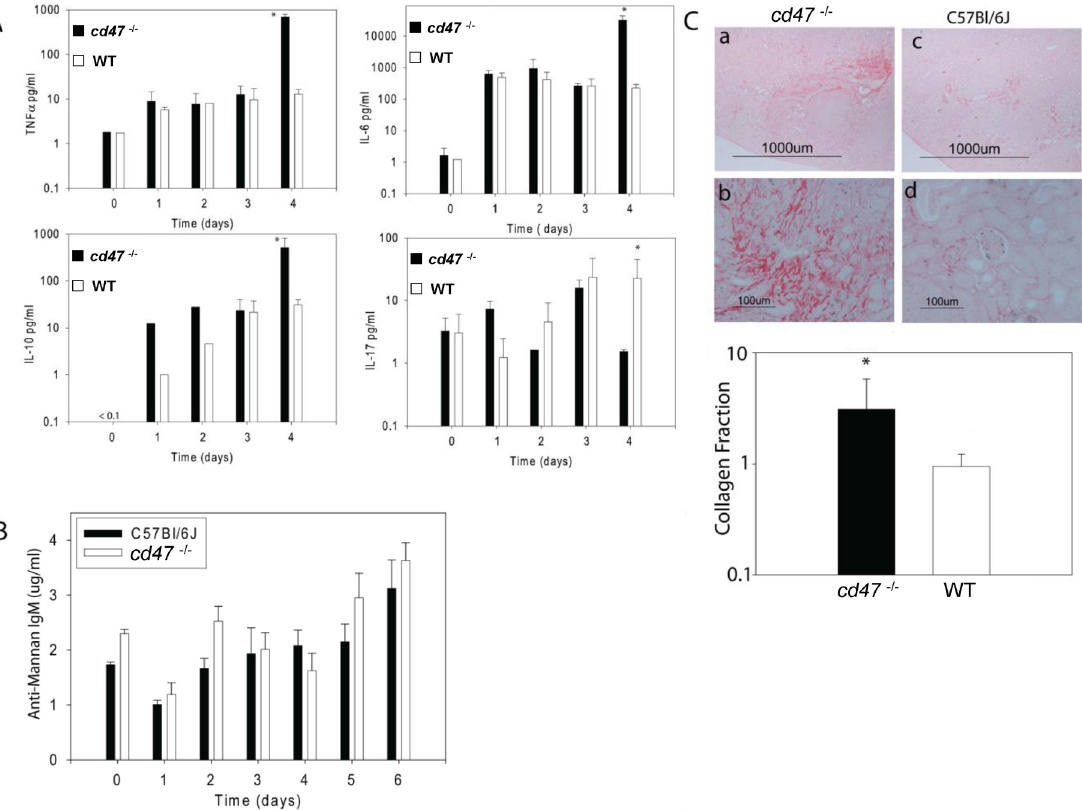
Fig 3. Inflammatory responses in WT and cd47 -/- mice associated with disseminated candidiasis. (A) Cytokine levels were compared in mouse sera at the indicated times post inoculation. 4 days PI is the crucial time for cd47 -/- mouse mortality at this inoculation dose. This point is associated with higher TNF α , IL-6 and IL-10 and lower IL-17. Protection against candidiasis in WT mice is associated with higher IL-17 and lower TNF α , IL-6 and IL-10. (B). Mannan-specific IgM levels in sera from infected WT and cd47 -/- mice. (C).Collagen staining with Sirius red to assess the level of fibrosis in Candida infected kidneys. cd47 -/- mice show more fibrosis, consistent with increased kidney failure. Bars represent mean ± SE morphometric quantification for nine representative sections from three mice of each group and analyzed using two-way ANOVA with post Bonferroni comparison test for A and B and Students t test for